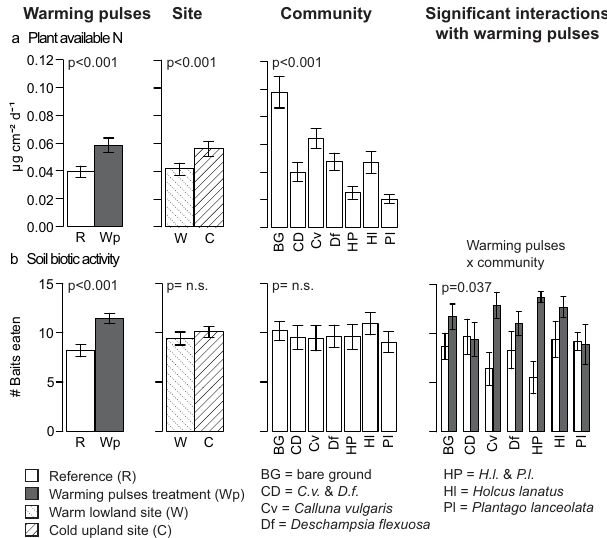
Figure 2. (a) Plant-available nitrogen (nitrate and ammonium; PRS ™ probes) and (b) soil biotic activity (bait-lamina test) dur- ing the manipulation period (18 December 2010–17 March 2011). Main winter warming pulses treatment, site and community effects and all significant interactions between the winter warming pulses treatment with site and community are shown. Mean ( ± SE) values are shown ( n = 140)